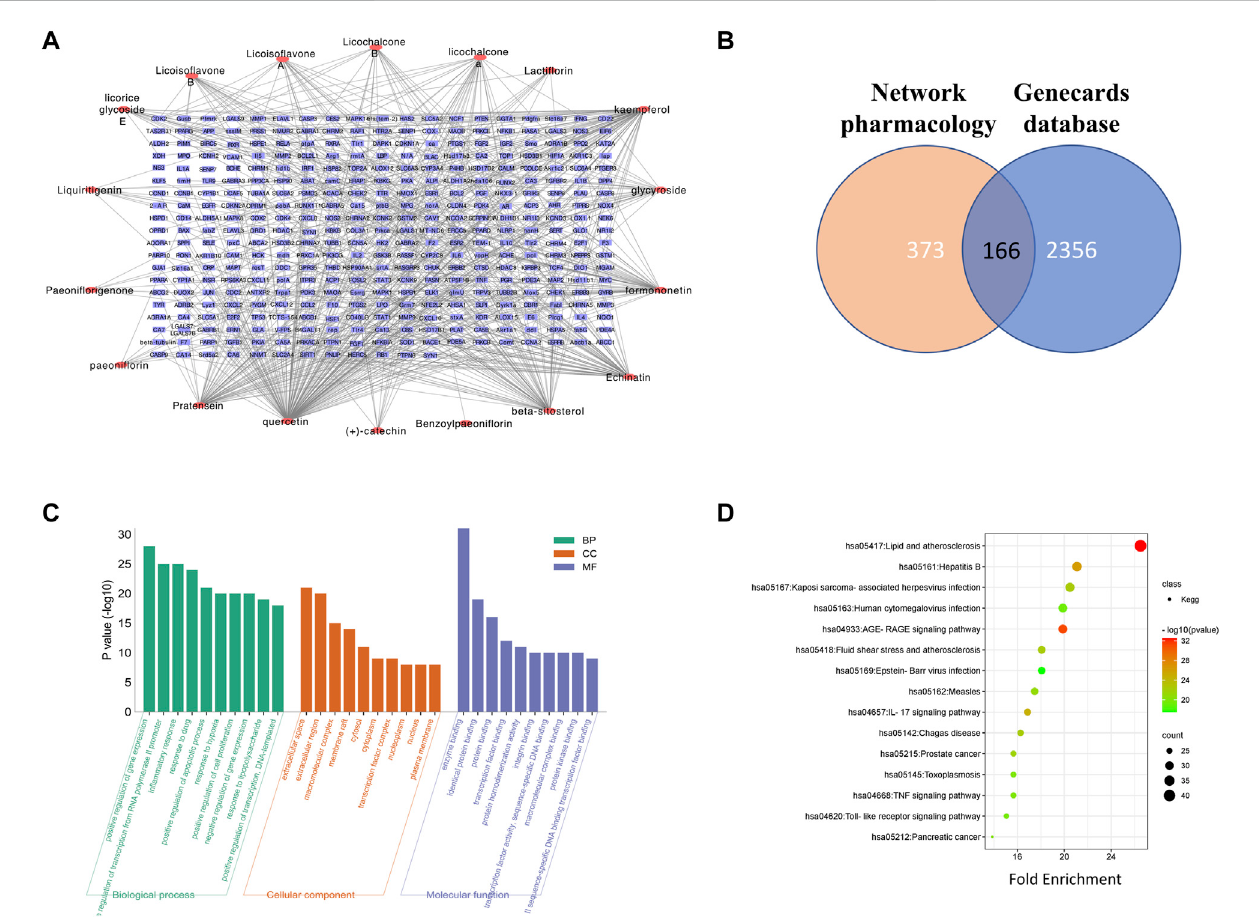
FIGURE 2 Network pharmacology analysis of GZD. (A) Compound – target network of GZD. (B) GO of the candidate targets of GZD against OA; the top 30 GO functionalcategorieswitha p -adjustedvalue < 0.05areselected. (C) KEGGpathwayenrichmentofcandidatetargetsofGZDagainstOA. (D) Pathwaysthathad signi fi cant changes of p < 0.05 are identi fi ed. Color denotes the p -value, and size of the spot represents the number of